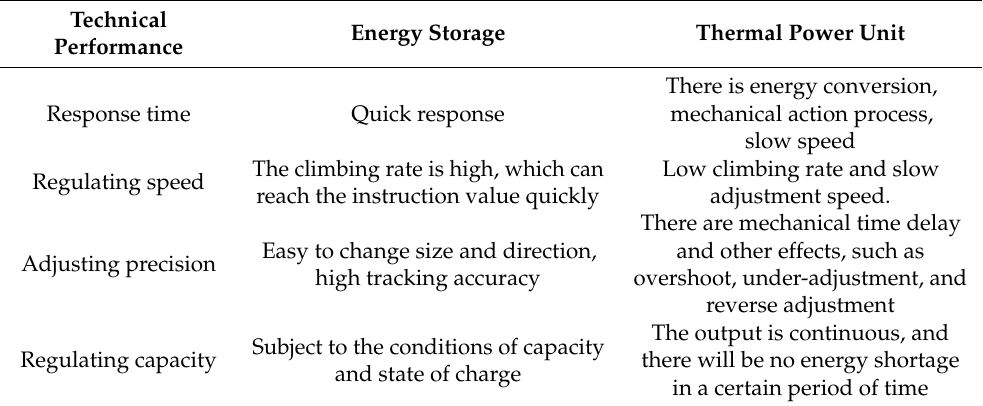
Table A2. Comprehensive comparison of energy storage and thermal power unit technical